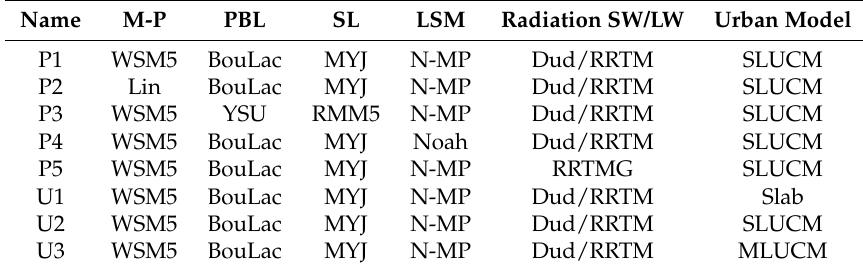
Table 1. Combinations of physical and urban parameterizations of Weather Research and Forecasting (WRF) used in this